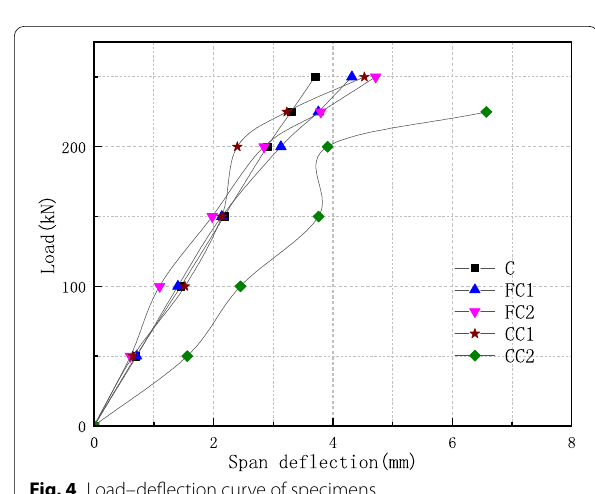
Fig. 4 Load–deflection curve of